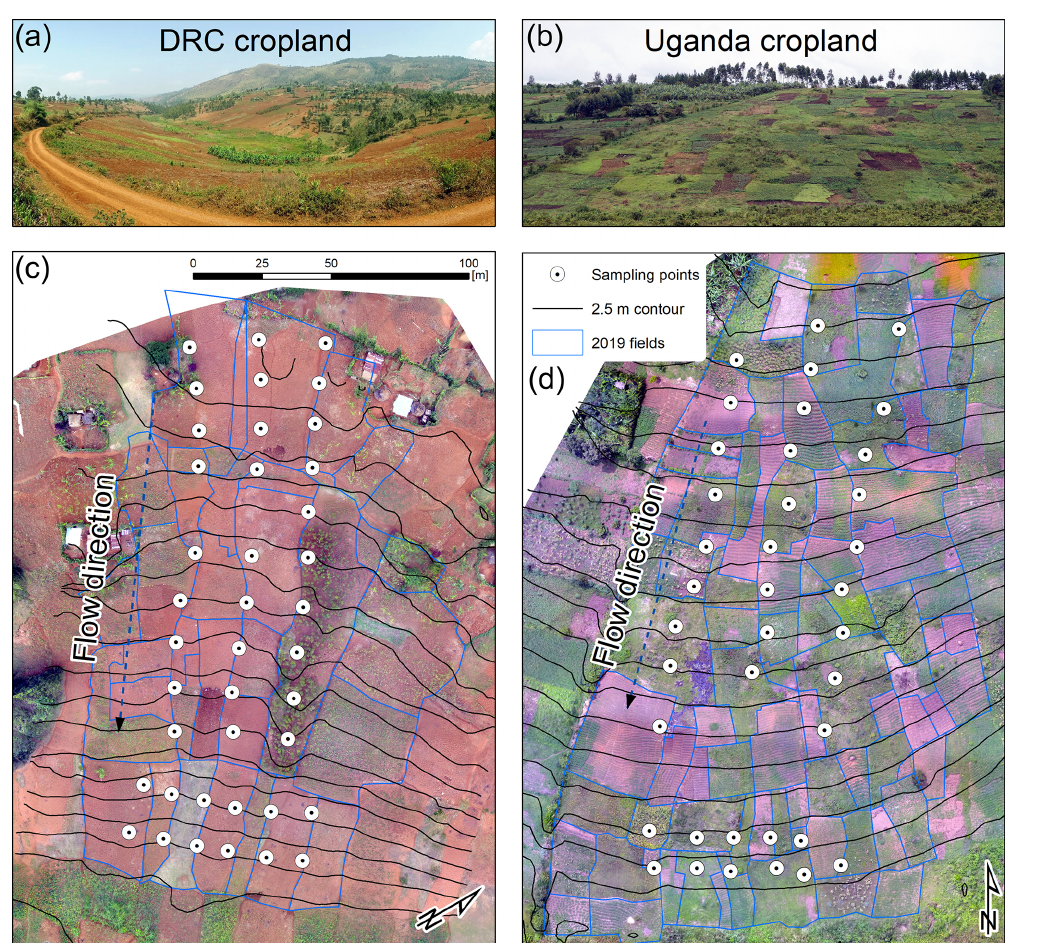
Figure A1. Overview photos and orthomosaics of the DR Congo (a, c) and Uganda (b, d) cropland sites. Image acquisition dates: DR Congo (a) overview photo 1 September 2018, (c) orthomosaic 14 September 2019; Uganda (b) overview photo 12 October 2019, (d) orthomosaic 12 June